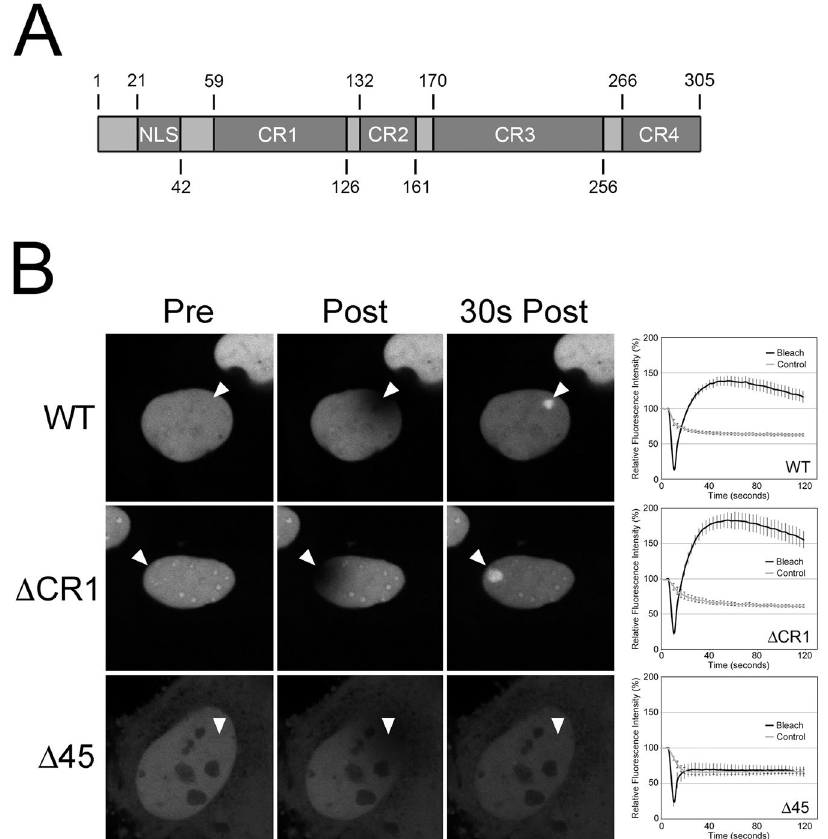
Figure 2. Recruitment of UL31 to sites of laser microirradiation requires its N-terminal 45 amino acids but not CR1. ( A ) Cartoon of HSV-2 UL31 identifying key features of the molecule including the position of the bipartite nuclear localization signal (NLS) as well as the positions of conserved regions (CR) 1 through 4. ( B ) Images of live HeLa cells expressing wild type EGFP-UL31 (WT), EGFP-UL31 lacking the CR1 region required for UL34 binding ( Δ CR1), or EGFP-UL31 lacking its N-terminal 45 amino acids ( Δ 45) acquired immediately before (Pre), immediately after (Post), and 30 seconds after the areas indicated by arrowheads were microirradiated using an Olympus FV1000 laser-scanning confocal microscope. The graphs display quantitation of the average fluorescence intensity of the irradiated area (Bleach), as well as distal control areas (Control), over time. Images shown are representative of n = 12 cells analyzed in two independent experiments. Error bars are standard error of the mean (n = 12 per